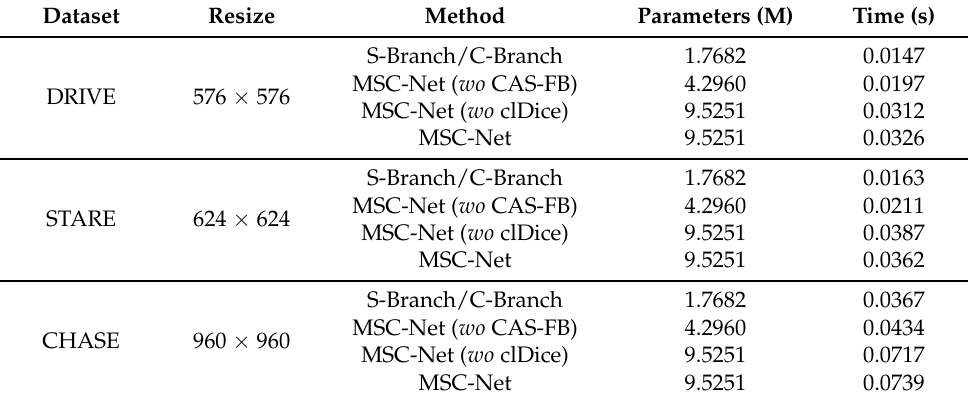
Figure 6. Visualization results after ablation of different modules. The first line of each case is the retinal image and vessel segmentation result, and the second line is the centerline result. The figure shows that the complete MSC-Net has better visualization results. Table 7. The parameters and reasoning time when ablating different modules of the